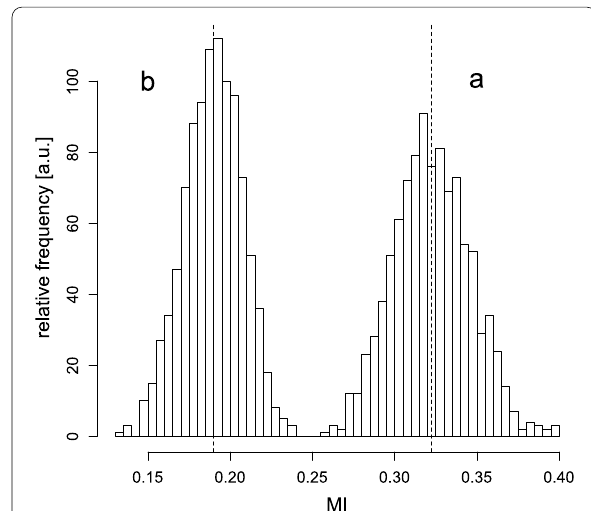
Fig. 6 MI distribution calculated from the bootstrapped samples (a: for the accepted registrations; b: for the rejected registrations). A vertical dashed line indicates the mean of MI values for both parts of the distribution (0.19 and